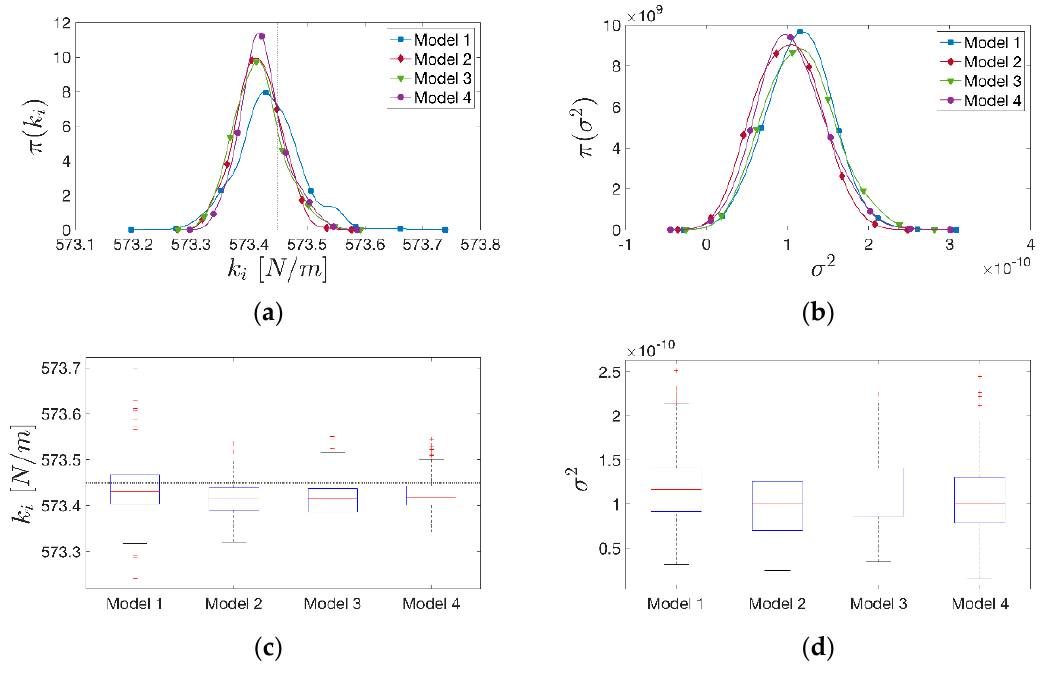
Figure 12. ( a ) Kernel density estimations (KDE) of the initial stiffness model parameter k i (on the left) and; ( b ) of the discrepancy variance σ 2 for each model (low-level of degradation, PGA ≈ 1 m / s 2 ). ( c ) Boxplot representations (based on the five-number summary: minimum, first quartile, median, third quartile and maximum) of the posterior samples for the model parameter k i and; ( d ) σ 2 . The horizontal and vertical dotted lines in the plots represent the calibrated reference value of k i